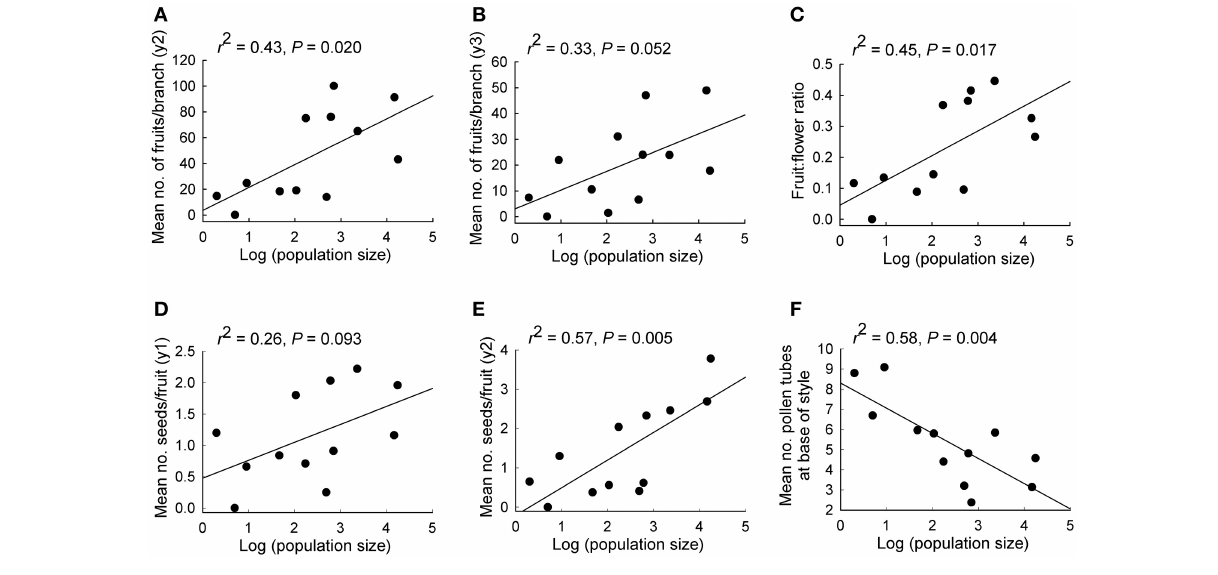
FIGURE 2 | Relationships between population size and various reproductive measures for 12 populations of Eucalyptus wandoo . Regression lines are presented with r 2 - and P -values. (A,B) the mean number of fruits per branch in each of two years, (C) fruit:flower ratio, (D,E) mean number of seeds per fruit in each of two years, (F) mean number of pollen tubes at the base of the